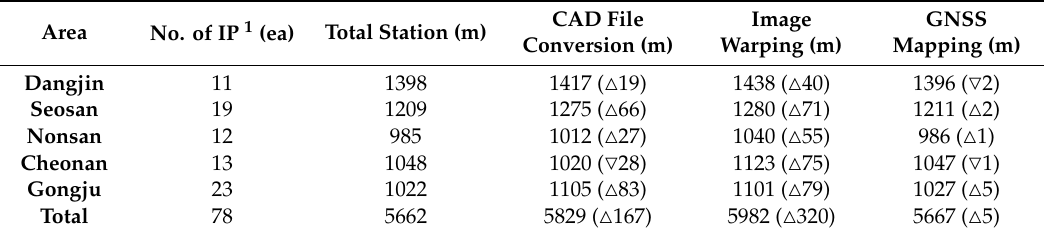
Table 2. Comparisons of the study route length by mapping technique.